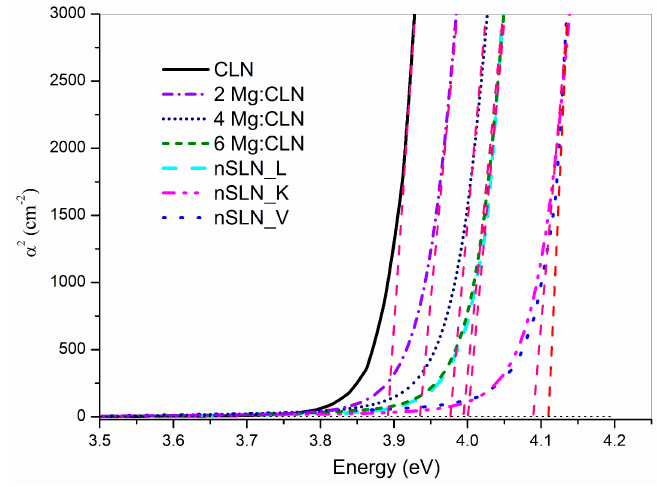
Figure 8. Dependence of α 1/2 on incident photon energy ( h ν ) for ( a ) Mg:CLN; ( b ) undoped CLN and nSLN crystals.